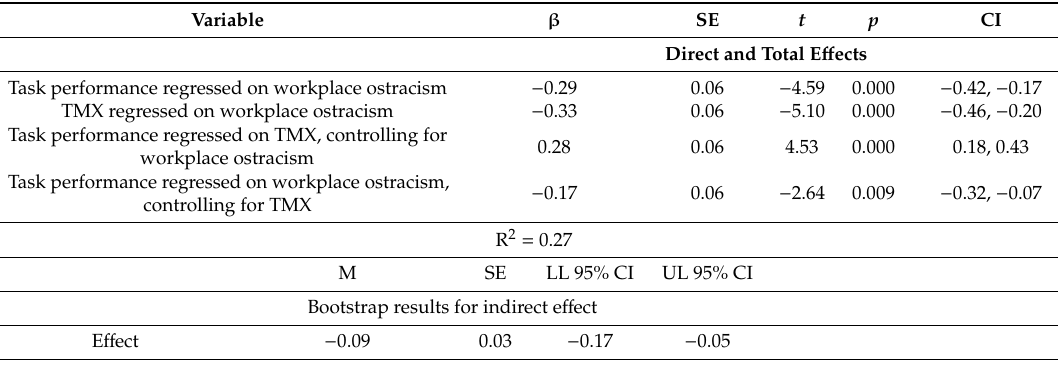
Table 2. Regressions results for